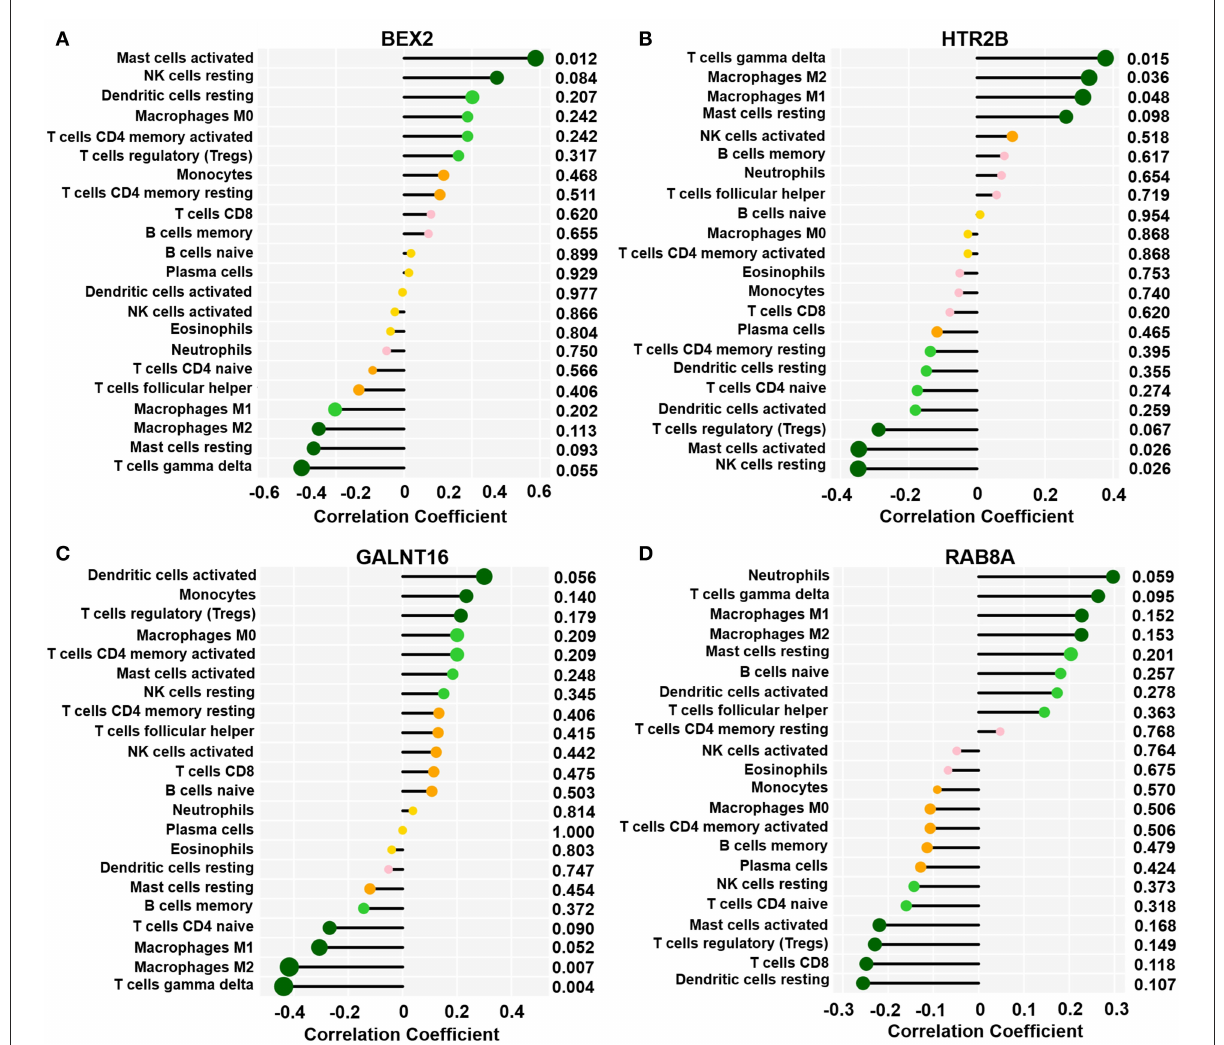
FIGURE6 Correlation between key genes and infiltrated immune cells. Representative graphs showing the correlation between the infiltrated immune cells and BEX2 (A) , HTR2B (B) , GALNT16 (C) and RAB8A (D) . Correlation strength is shown by the dot size; the p values are expressed as the changes in dot color. p < 0.05 represented a significant